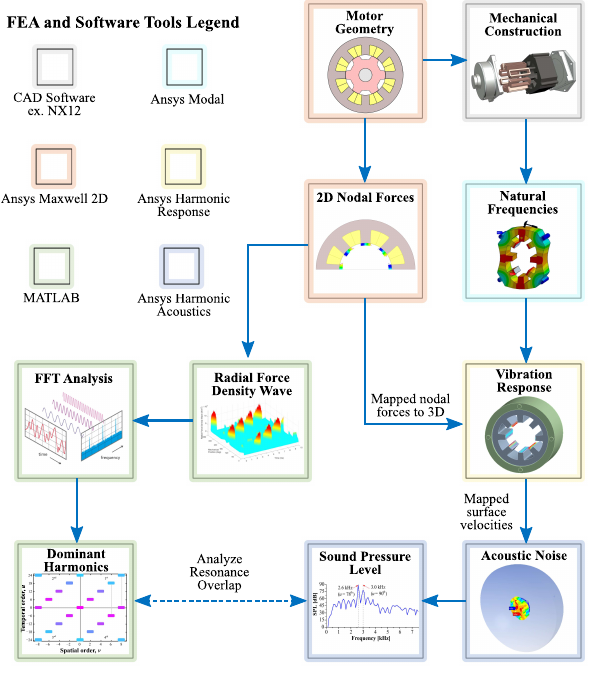
Figure 5. Block diagram of the multiphysics FEA toolchain for SRM acoustic noise